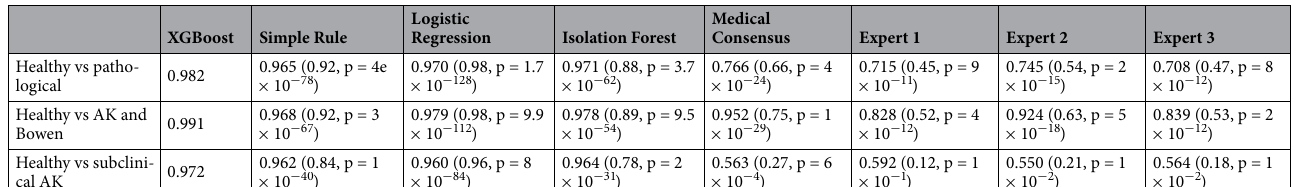
Table 3. AUC scores for different subsets of the data for different methods (and their Pearson correlation to XGBoost and